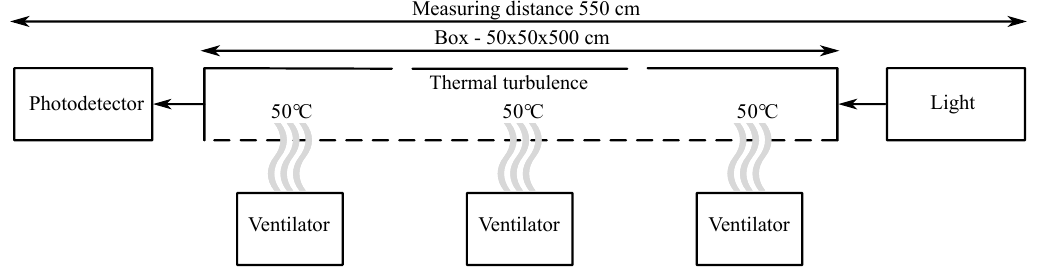
Figure 18. Octavia tail-light setup adjusted for scenario 2-thermal